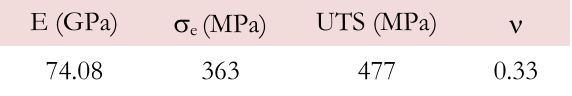
R ESIDUALS STRESSES DISTRIBUTION DUES TO COLD